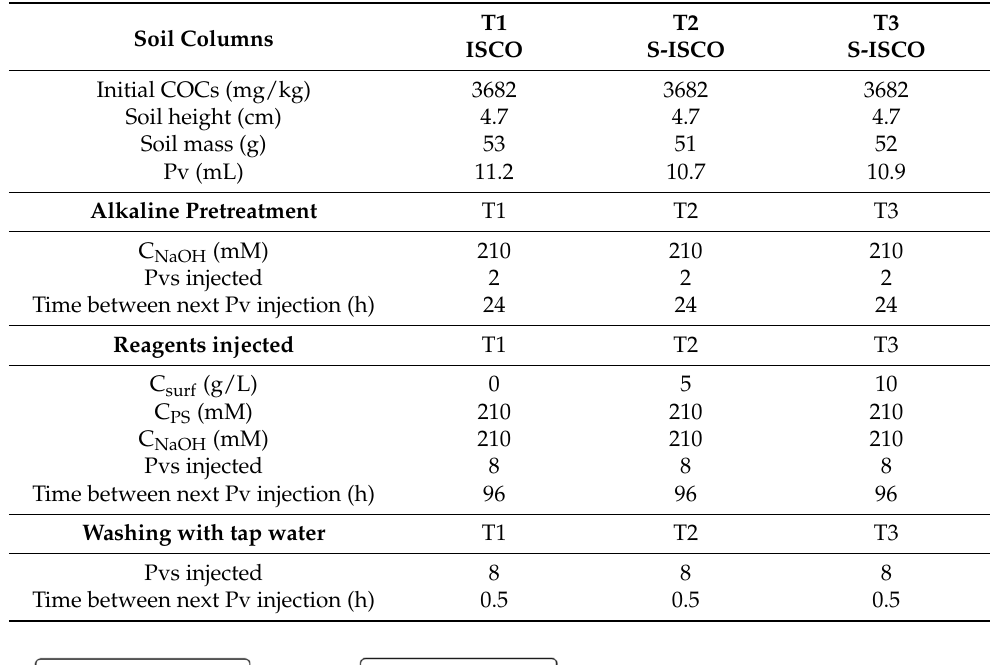
Table 5. Experimental conditions in column runs. The flow rate used in all Pv injections was 0.3 mL/min.